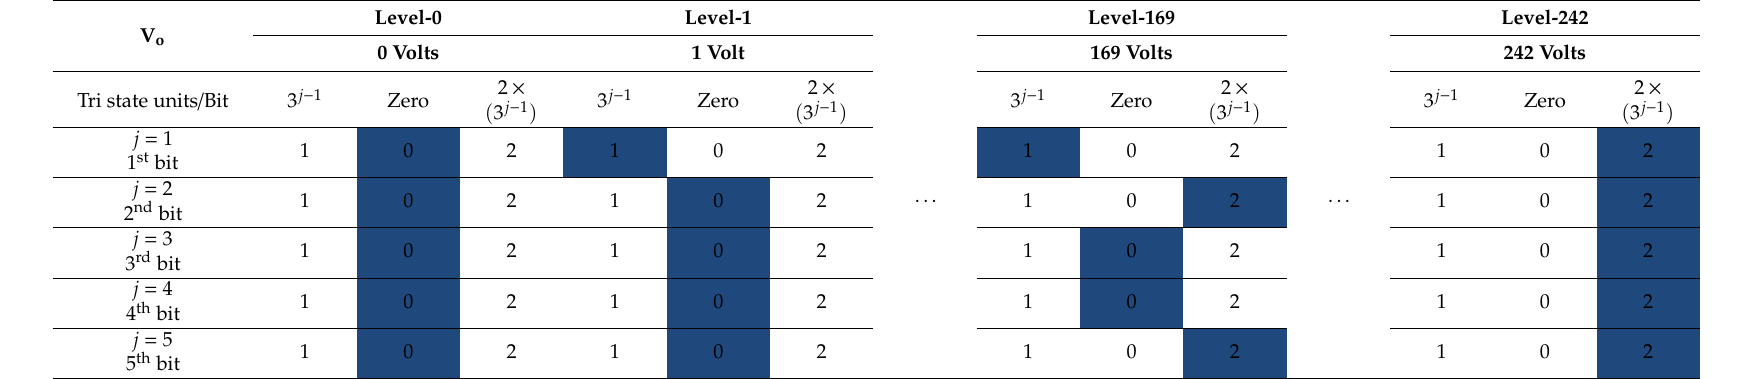
Table 3. Level generation pattern of a Tri-State